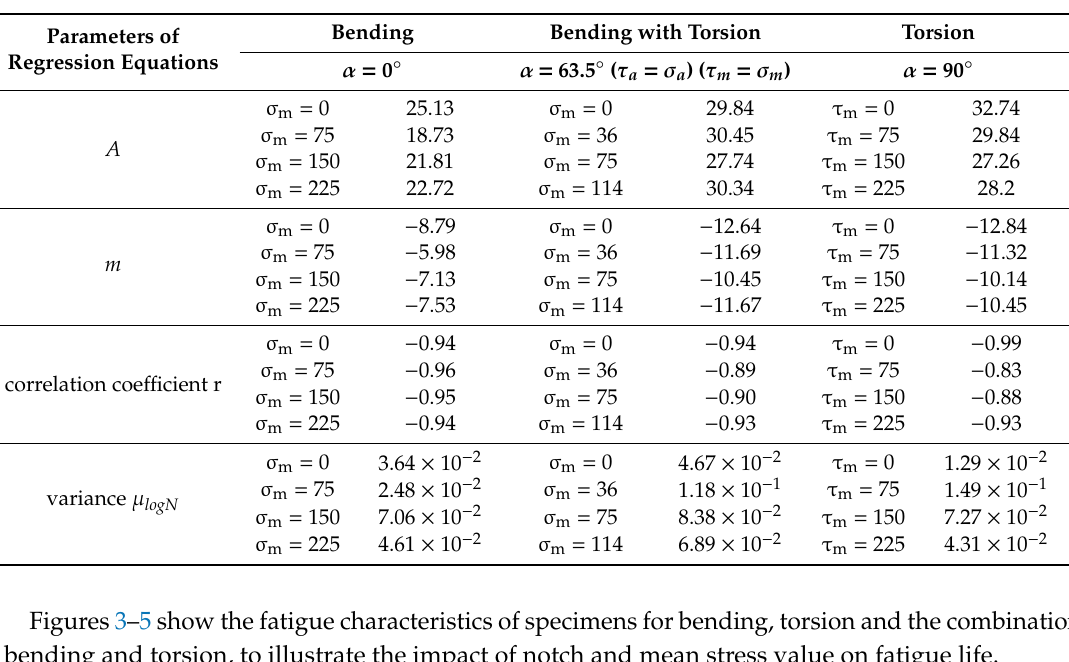
Table 4. Parameters of regression equations describing fatigue life of notched specimens.